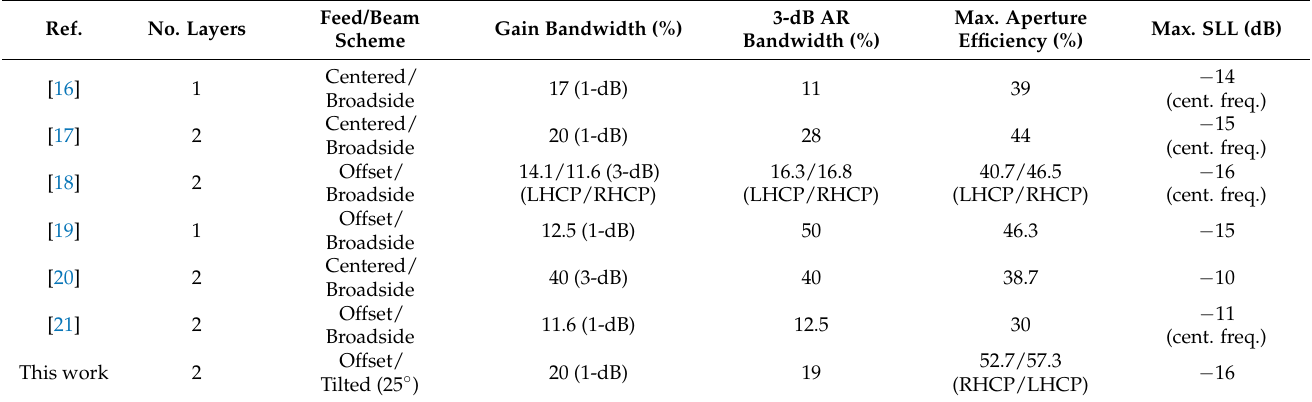
Table 1. Comparison of this work with previously reported polarizer reflectarrays.